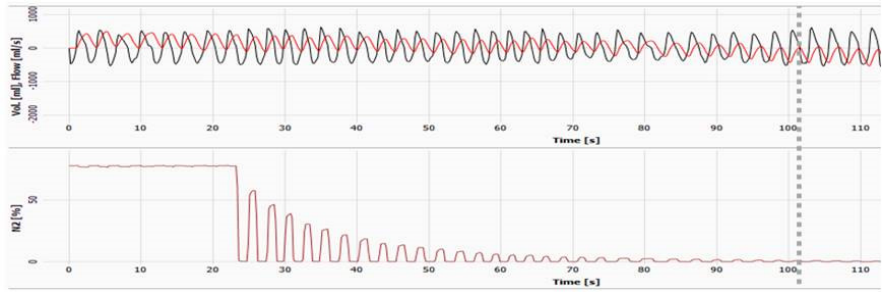
Figure 1. Multiple breath washout performed on a healthy subject. Top red line shows volume, whilst in black is the flow. The nitrogen (N 2 ) trace shown in by the burgundy line, is used as the tracer gas, and it is “washed out” with 100% oxygen. During inspiration of 100% oxygen the N 2 goes to 0%, whereas during expiration the breath is captured. N 2 decreases in a step-like manner throughout the washout. Only 80 s of 100% oxygen breathing is required to reduce N 2 down to the target concentration (dashed grey line = 2.5% of the starting N 2 concentration hence LCI 2.5 ). Subject has a normal LCI 2.5 of 6.50.